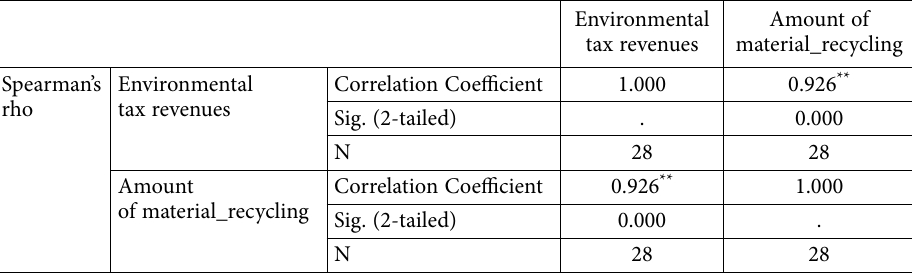
Table 3. Correlations between environmental tax revenues and landfill/disposal rate (source: Own elaboration based on Eurostat data, 2018) environmental Landfill/disposal tax revenues rate Spearman’s environmental tax Correlation Coefficient 1.000 –0.515 ** rho revenues Sig. (2-tailed) . 0.005 N 28 28 Landfill/disposal rate Correlation Coefficient –0.515 ** 1.000 Sig. (2-tailed) 0.005 . N 28